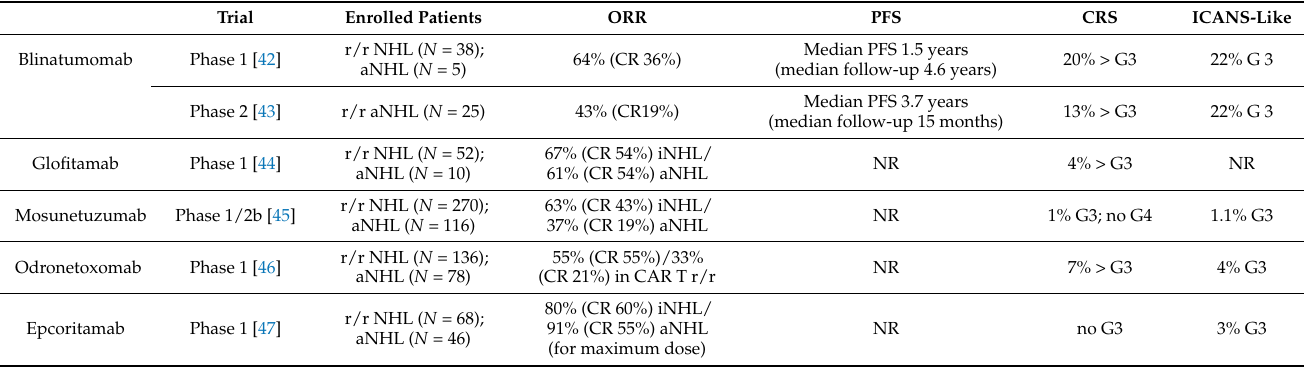
Table 1. Summary of principal reported